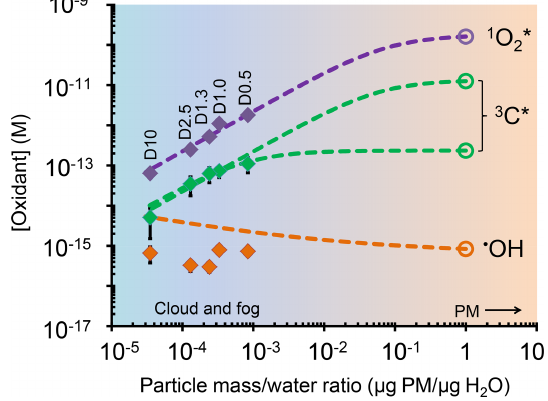
Figure 5. Dependence of photooxidant concentrations on particle mass/water mass ratio (i.e., aqueous particle concentration) in ex- tracts of sample PME3. Solid diamonds are measured values under experimental dilution conditions (typical for clouds or fogs), while the open circles are values expected in more concentrated particle liquid water based on the dashed line extrapolations. For the solid symbols, error bars ( ± 1 σ ) are often smaller than the symbols. Data labels on the diamonds (e.g., D10) represent the water volume used to extract the PME3 filter square (Sect. 2.5.4). The dashed line ex- trapolations include the contributions from both aqueous processes and interactions with the gas phase (Sect. S4). For oxidizing triplets, two extrapolation scenarios are shown: a best estimate (lower line) and a high estimate (upper line), as described in Sect. S4 and Ta- ble